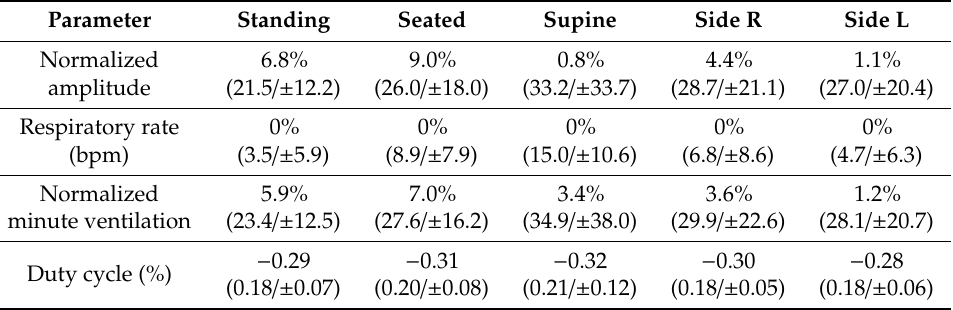
Table 2. Test at rest, all positions, all parameters. Aggregated data are expressed as relative error median percentage, interquartile range (IQR) and limits of agreement (LOAs), computed as ± 1.96SD. IQR and LOAs are presented in brackets (IQR / LOAs).